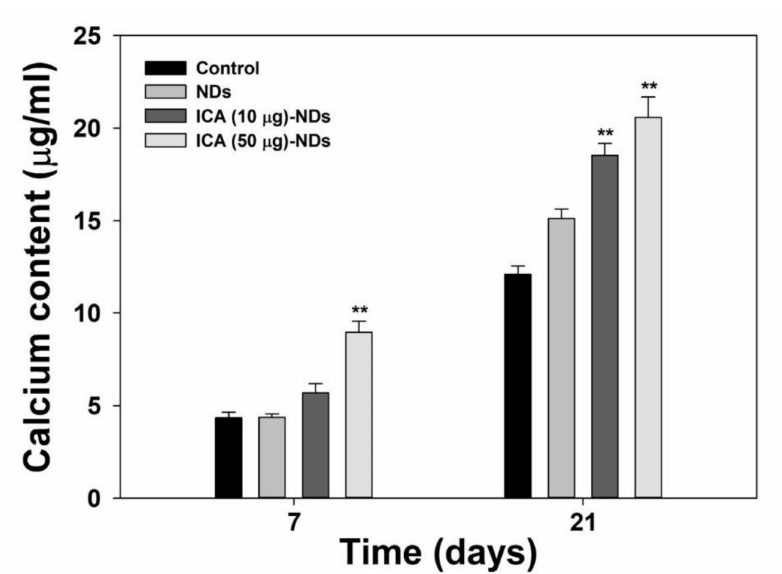
Figure 7. The calcium levels in MC3T3-E1 cells treated with NDs, ICA (10 µ g)-NDs, and ICA (50 µ g)-NDs after 7 and 21 days of culture ( n = 4 / group). ** p < 0.01.